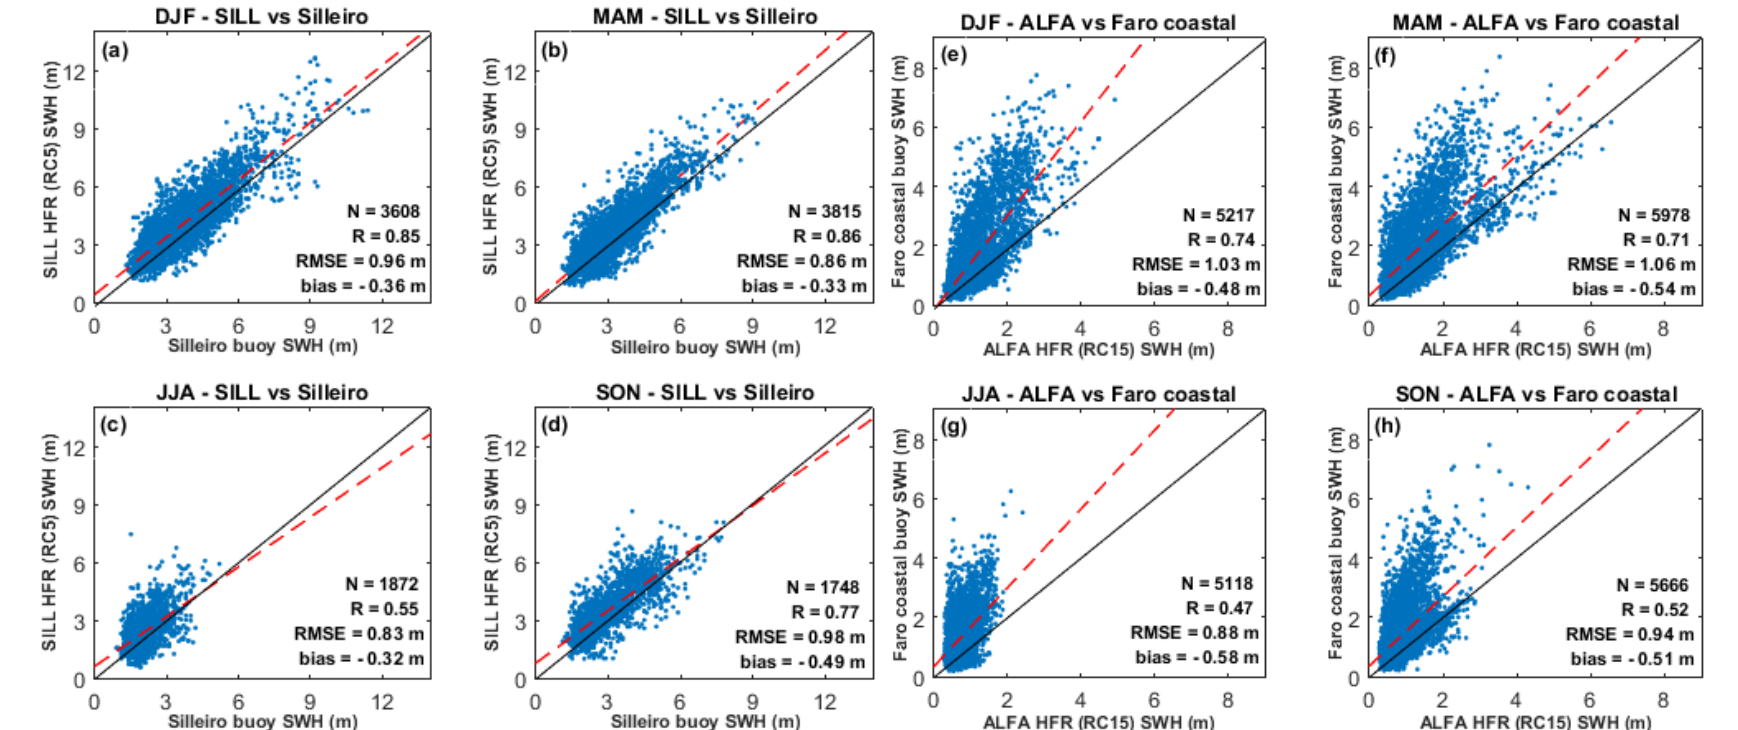
Figure A2. Seasonal comparisons between HFR SWH and buoy (scatter plots). Seasons: DJF—December, January, February; MAM—March, April, May; JJA—June, July, August, and SON—September, October, November. Statistics metrics are gathered on the right bottom side. N represents the number of coincident hourly observations, and the red dashed lines are the best linear fit of the scatter plots. ( a ) DJF–SILL vs. Silleiro; ( b ) MAM–SILL vs. Silleiro; ( c ) JJA–SILL vs. Silleiro; ( d ) SON–SILL vs. Silleiro; ( e ) DJF—ALFA vs. Faro coastal; ( f ) MAM–ALFA vs. Faro coastal; ( g ) JJA–ALFA vs. Faro coastal, and ( h ) SON–ALFA vs. Faro coastal.